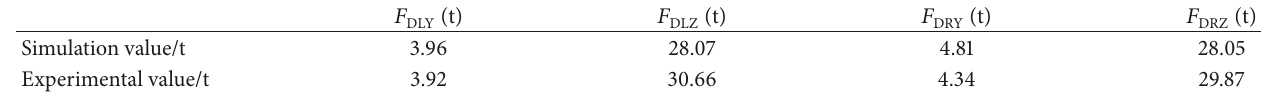
Table 9: Comparison of forces acting on guiding support plate pin